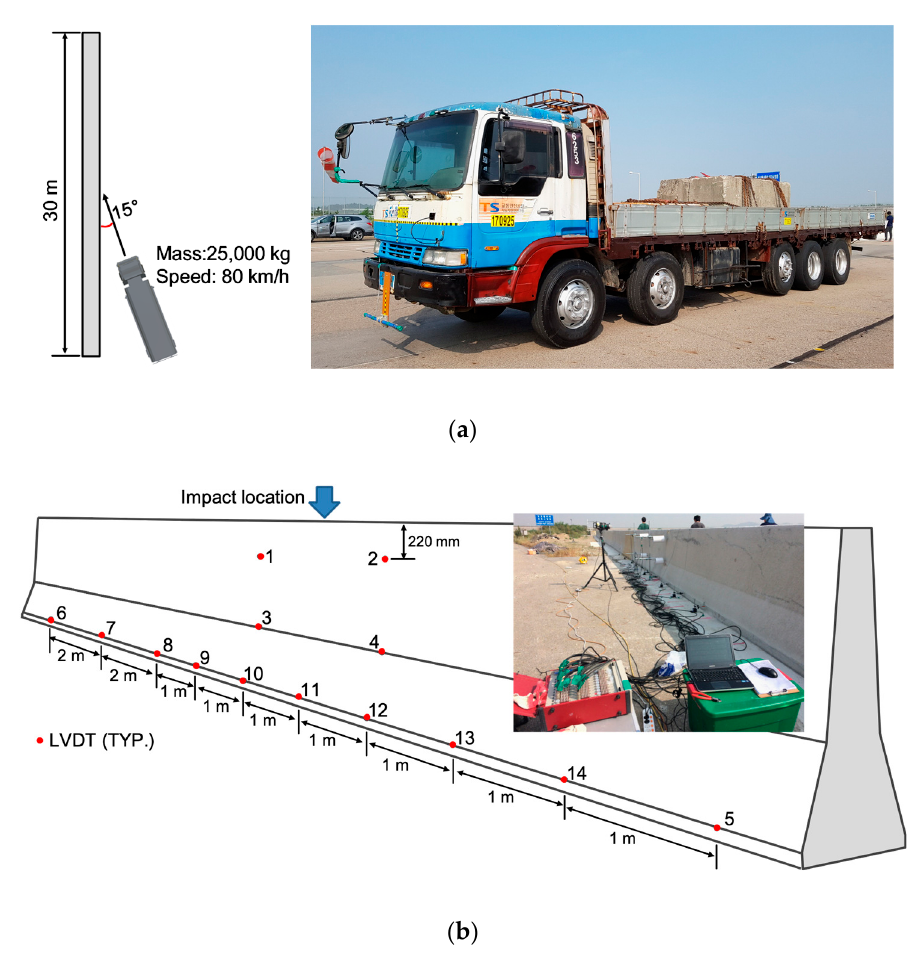
Figure 12. Test set-up. ( a ) Test vehicle; ( b ) Locations of the linear variable differential transformer (LVDT).